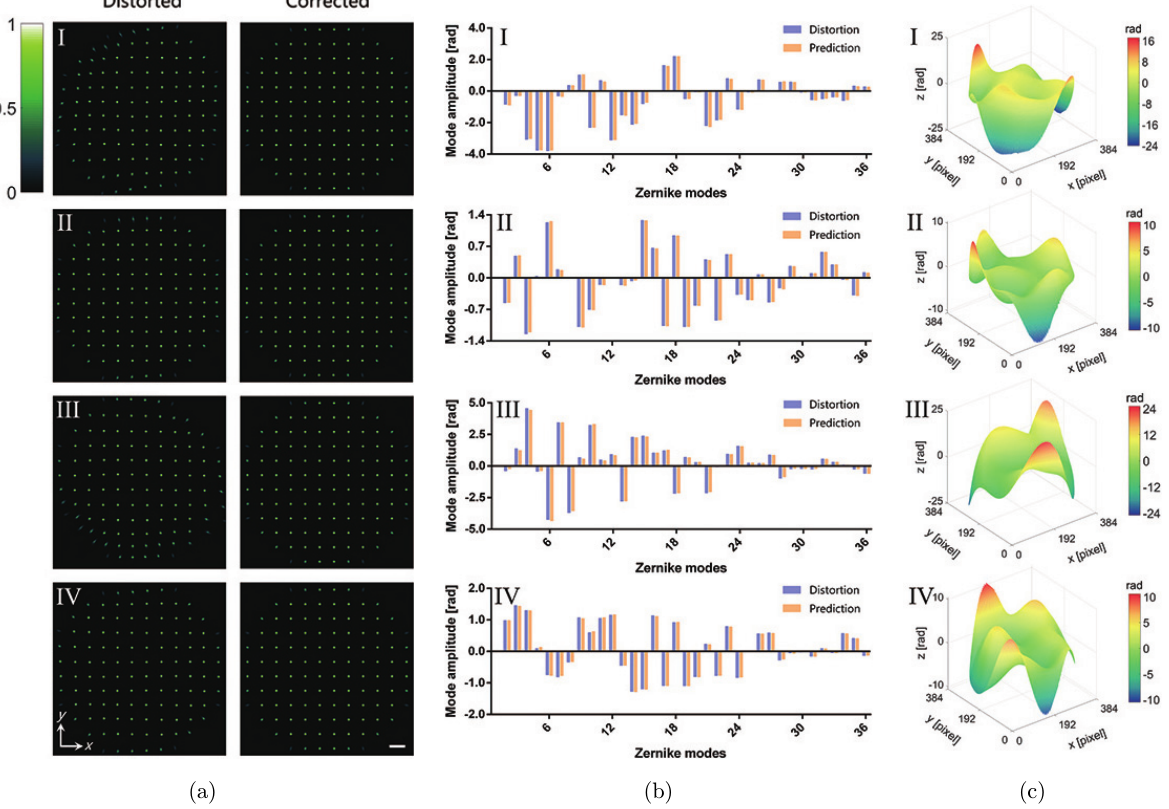
Fig. 5. Repeatability veri¯cation results for distortions prediction and correction. (a) The normalized intensity distribution of distorted spot patterns (left) and corrected spot patterns (right) captured on SHWS. The scale bar is 400 (cid:2) m. (b) Amplitude comparison of 36 Zernike mode coe±cients between distorted wavefront (purple) and predicted wavefront (orange). (c) 3D distribution of the predicted